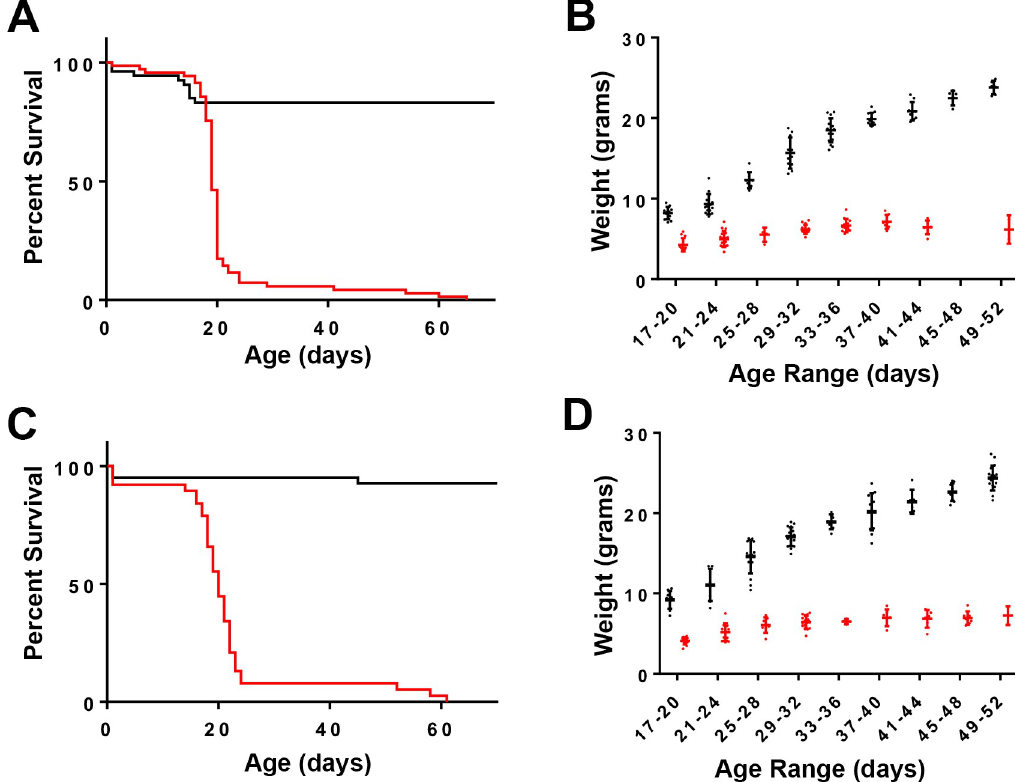
Fig 2. Survival and weights of genetically modified mice. A. Kaplan-Meier plot showing proportional survival of Braf CA (black line, n = 53) and Braf CA Tg(CD207-cre) (red line, n = 69) littermates. The median survival of Braf CA Tg(CD207-cre) mice was 19 days. P < 0.0001 by log-rank test. B. Weights of Braf CA (black dots) and Braf CA Tg(CD207-cre) (red dots) mice. Horizontal bars show means. p � 8.9 x 10 − 7 by t-test for all time points. C. Kaplan-Meier plot showing proportional survival of Braf CA Pten loxP/loxP mice (black line, n = 41) and Braf CA Pten loxP/loxP Tg(CD207-cre) littermates (red line, n = 38). The median survival of Braf CA Pten loxP/loxP Tg(CD207-cre) mice was 20 days. P < 0.0001 by log-rank test. D. Weights of Braf CA Pten loxP/loxP (black dots) and Braf CA Pten loxP/loxP Tg(CD207-cre) (red dots) mice. Horizontal bars show means. p � 2.8 x 10 − 7 by t-test for all time points.